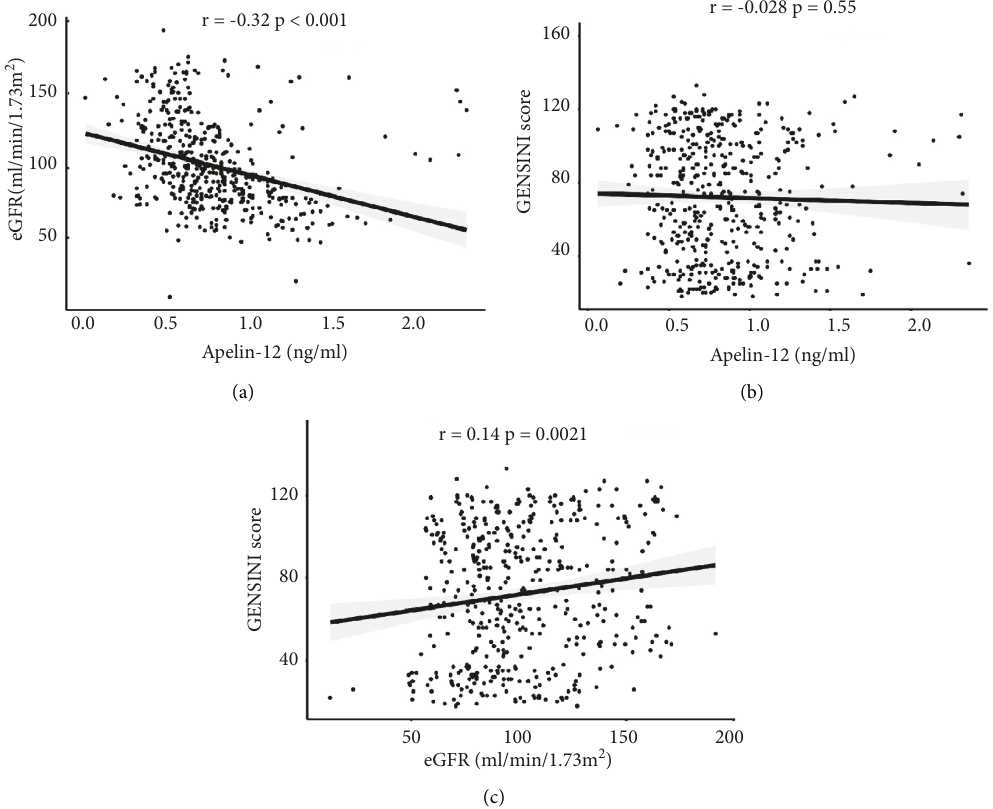
Figure 4: Relationships between apelin-12 or eGFR and Gensini score. (a) Relationship between apelin-12 and eGFR. (b) Relationship between apelin-12 and Gensini score. (c) Relationship between eGFR and Gensini score. eGFR: estimated glomerular filtration